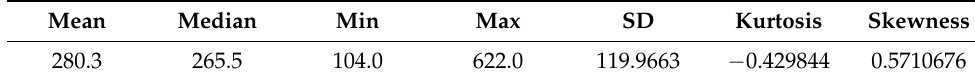
Table 1. Statistical characteristics of the “nottem” dataset. Mean Median Min Max SD Kurtosis Skewness 280.3 265.5 104.0 622.0 119.9663 − 0.429844